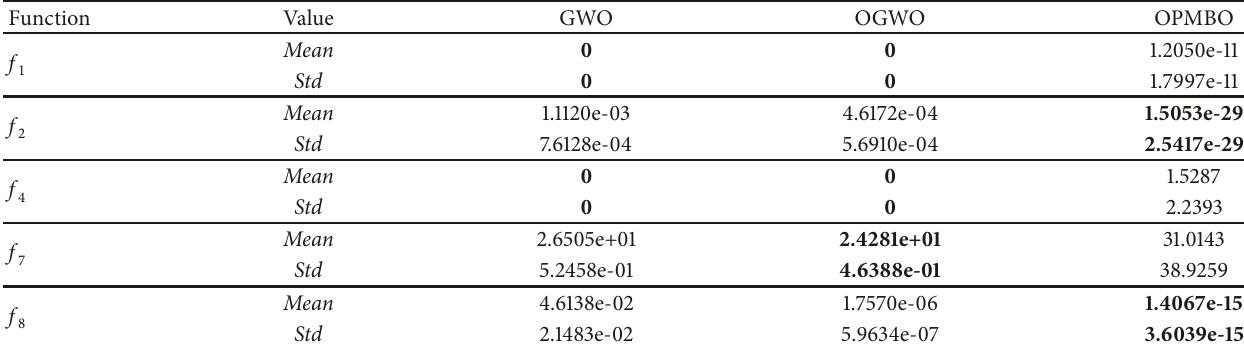
Table 8: The comparison of OPMBO with two GWOs on 30 dimensions with a population size of 20. Function Value GWO OGWO